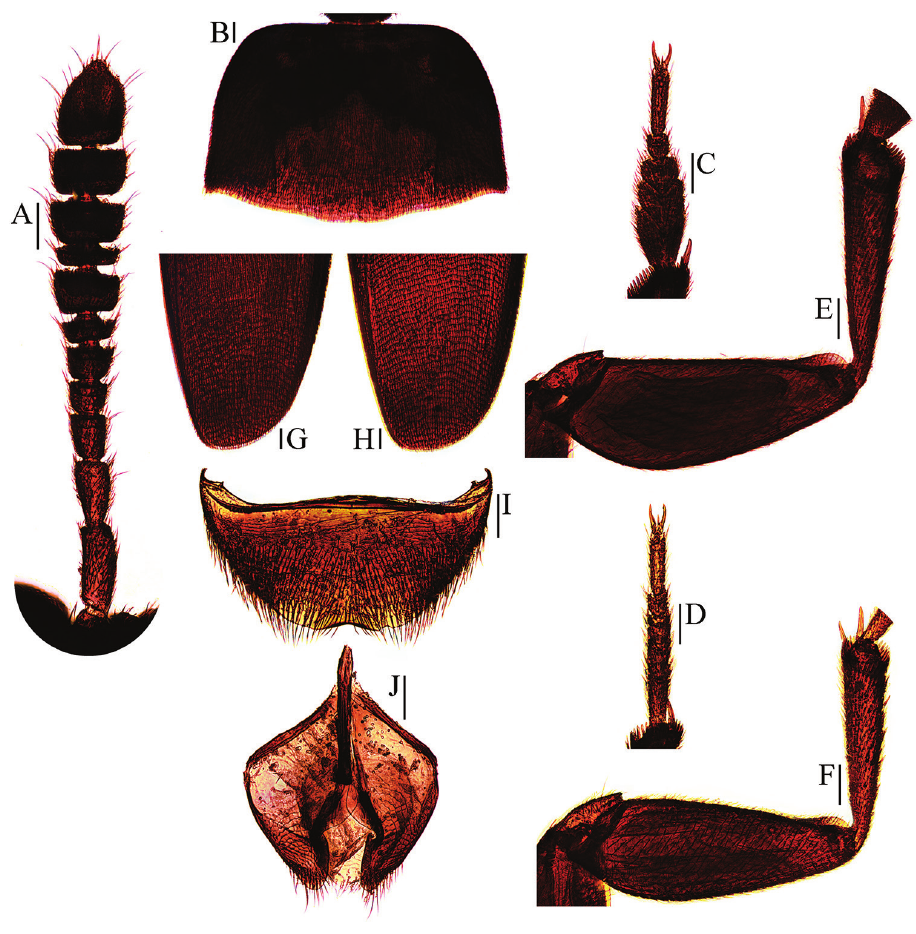
Figure 8. Ptomaphagus (s. str.) haba sp. n. ( ♂ : paratype; ♀ : paratype). A antenna ♂ (dorsal view) B pro- notum ♂ (dorsal view) C protarsus ♂ (dorsal view) D protarsus ♀ (dorsal view) E protibia and profemur ♂ (ventral view) F protibia and profemur ♀ (ventral view) G elytral apex ♂ (dorsoapical view) H elytral apex ♀ (dorsoapical view) I ventrite VIII ♂ (ventral view) J genital segment ♂ (ventral view). Scale bars: 0.1